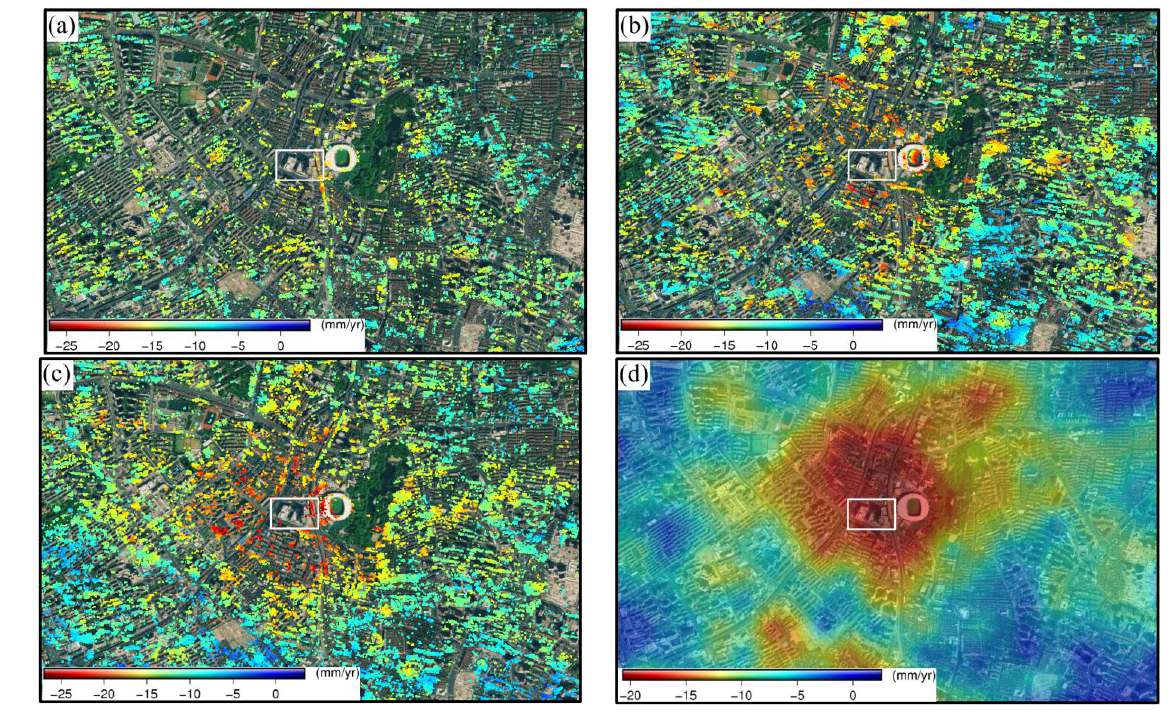
Figure 9. The enlarged maps of VDRs around the subsiding bowl derived from the single- and multi-platform SAR images, which are superimposed onto the high-resolution optical image obtained from Google Earth. ( a – c ) show the maps of VDRs at all the TCPs derived through the TCPInSAR processing for the three cases of single-platform SAR images acquired by the ascending CSK, descending CSK, and descending TSX, respectively; ( d ) shows the map of improved VDRs derived through the localized LS method with use of the multi-platform SAR images.